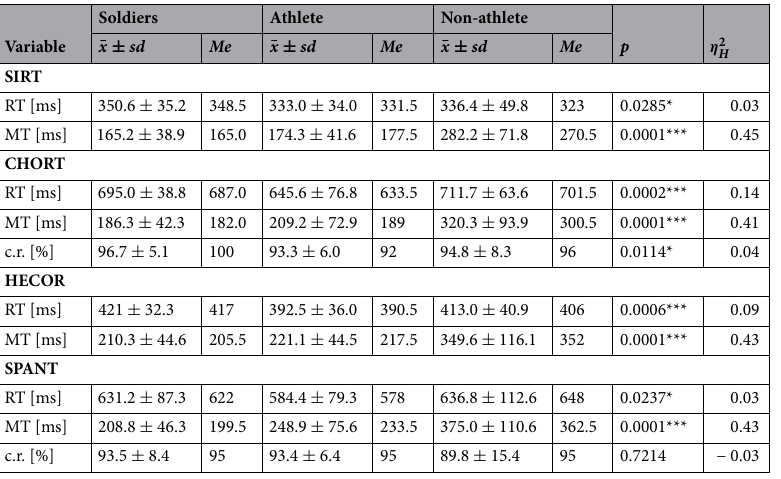
Table 1. Numeral characteristics of psychomotor abilities of groups. SIRT simple reaction time, CHORT choice reaction time, HECOR hand-eye coordination test, SPANT spatial anticipation test, RT reaction time, MT movement time, c.r. correct responses, Wallis test.